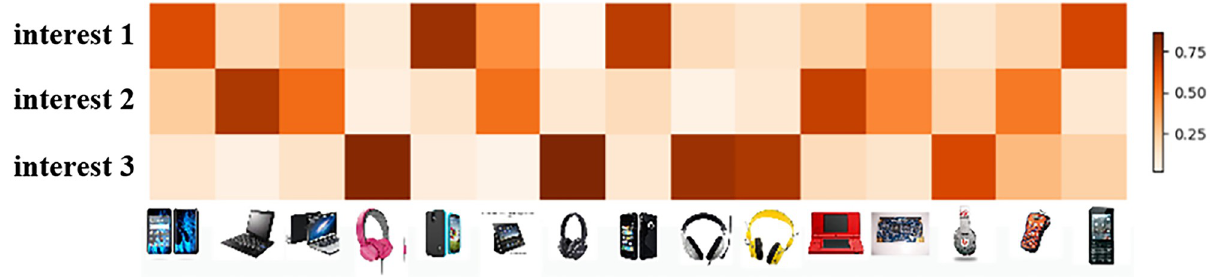
Fig 5. Heatmap of coupling coefficients for user behaviors. Each behavior has a corresponding coupling coefficient in the corresponding capsule of interest.